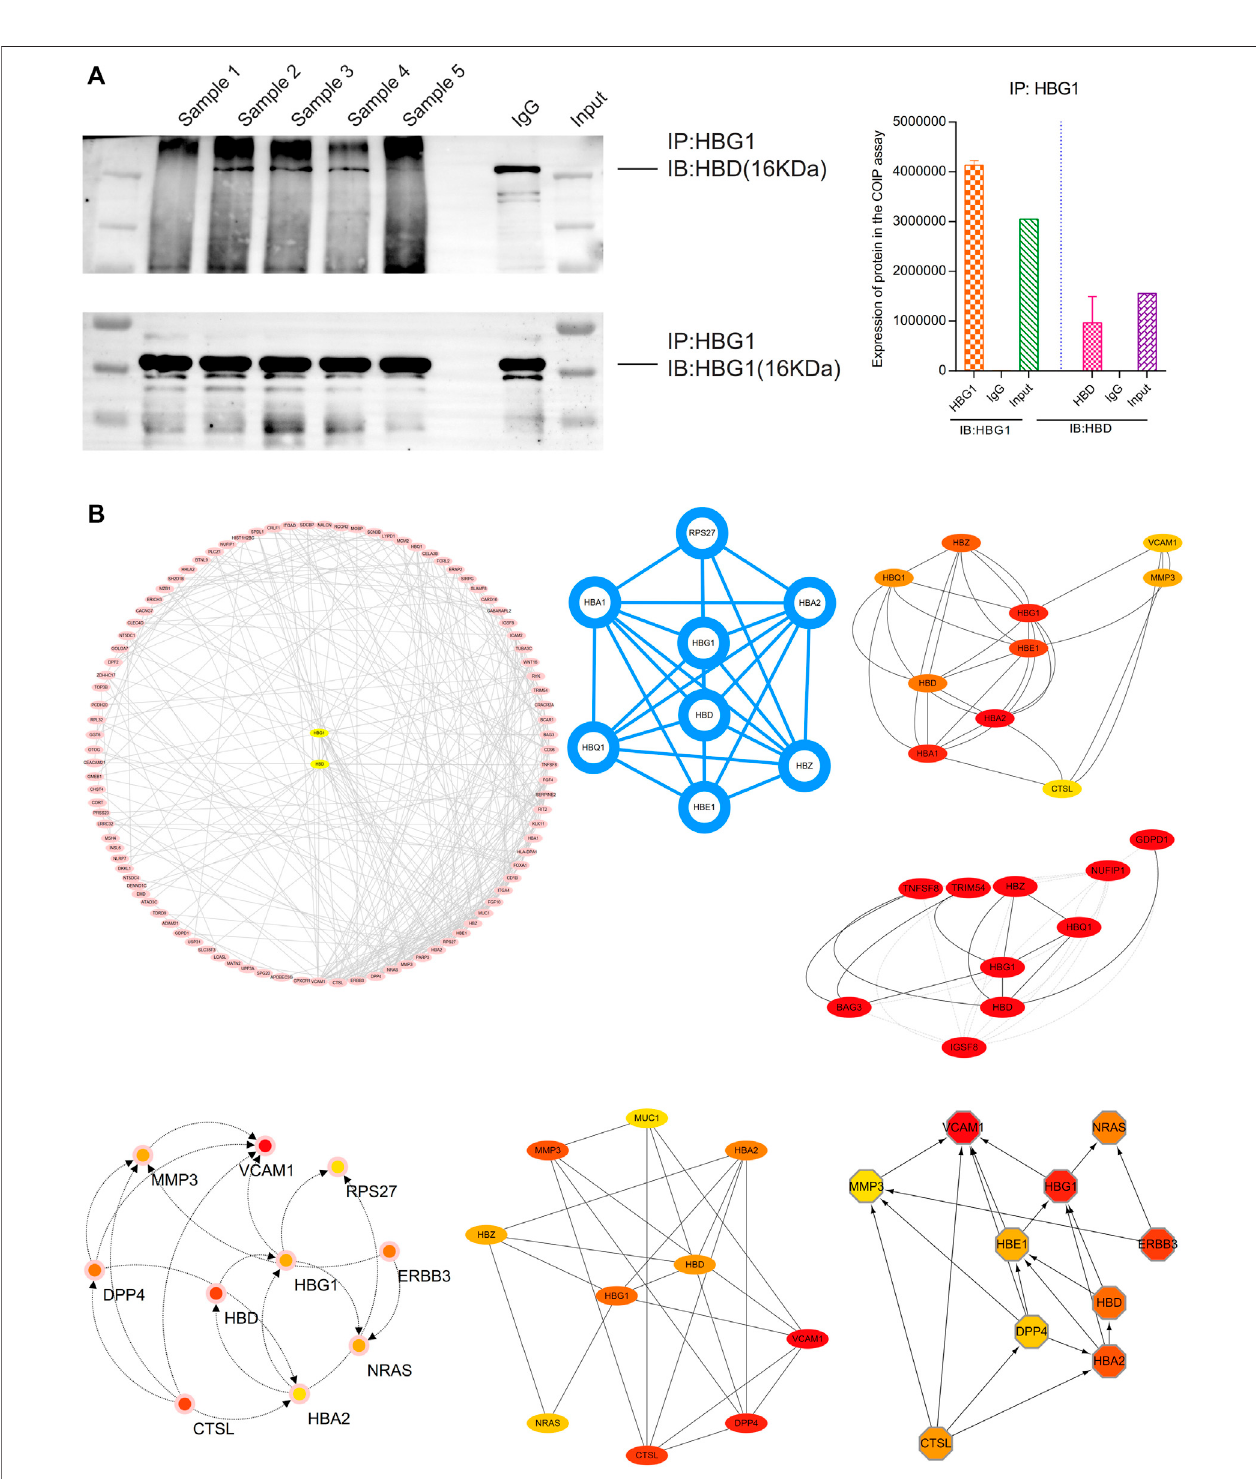
FIGURE10| StronginteractionbetweenHBG1andHBD. (A) HBG1andHBDwereco-expressedinthebloodviatheCOIPassay. (B) HBG1andHBDwereatthe core of the PPI network. Furthermore, through calculation by MCODE and cytoHubba, HBG1 and HBD were hub genes in the network, and there was a strong interaction between HBG1 and HBD.